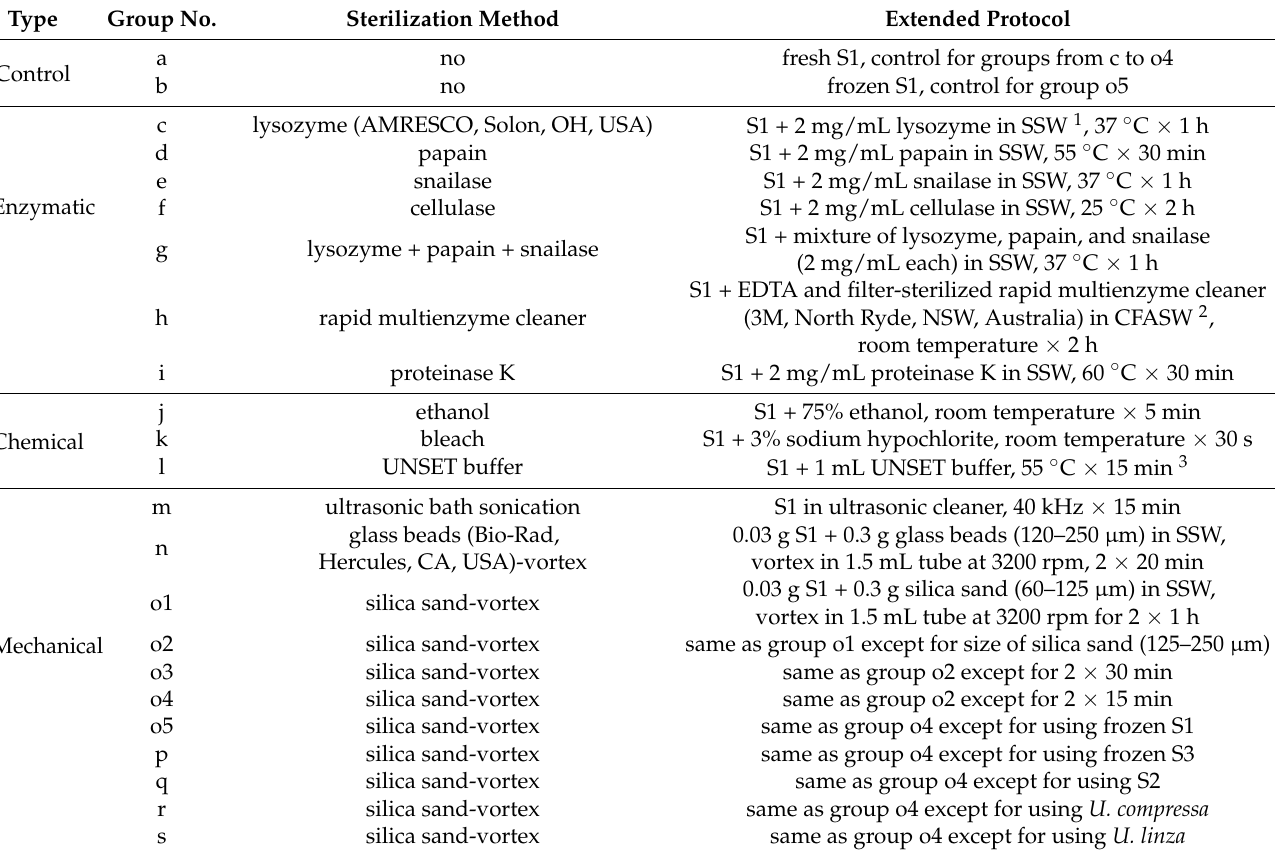
Table 1. Protocols applied for the surface sterilization of Ulva